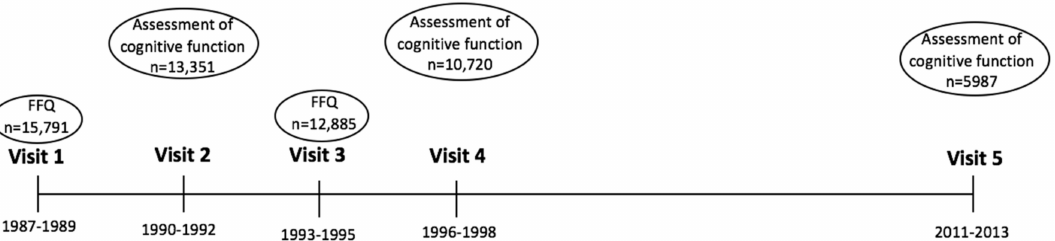
Figure 1. Timeline of the Atherosclerosis Risk in Communities (ARIC)